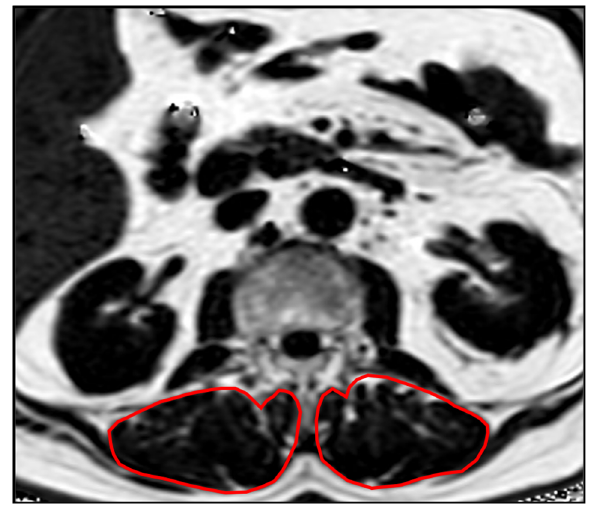
Figure 1. Example PDFF map showing the segmentations of the PSM. The mean vertebral and PSM PDFF and vertebral T2* values of each patient were calculated as the average of the values derived from the five slices. The changes of PDFF and T2* values of both the lumbar spine and the PSM were calculated as the difference between the follow-up values after 6 months and the baseline values.